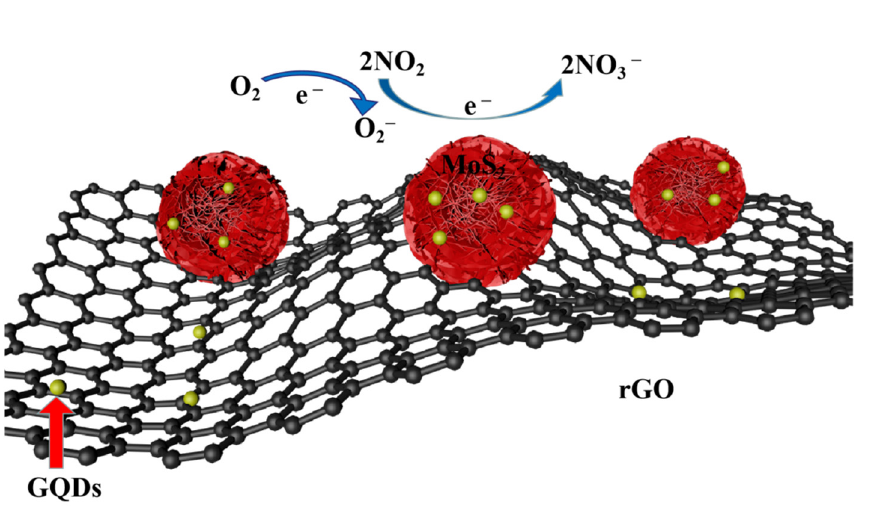
Figure 13. Schematic illustration of the gas sensing mechanism for MoS 2 /rGO/GQDs composites.